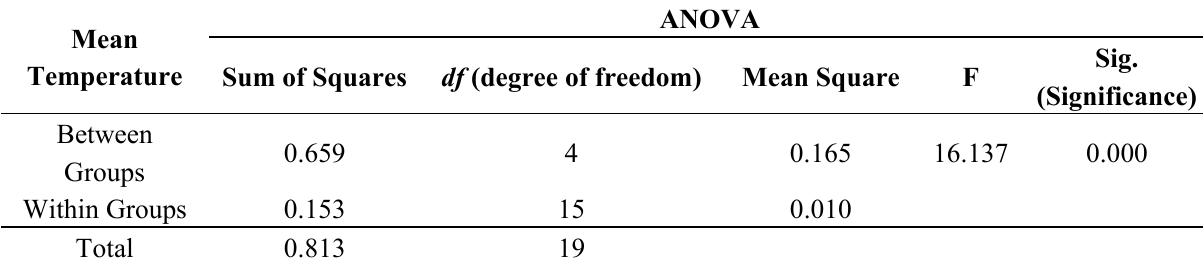
Figure 1. Leaf temperature under different water stress shows gradient variances. The peak temperatures of both groups C and D were approximately 21.1 °C. The soil moisture differences of each group can be reflected in peak value of canopy temperature. Table 1. Analysis of the differences in canopy temperature within and between